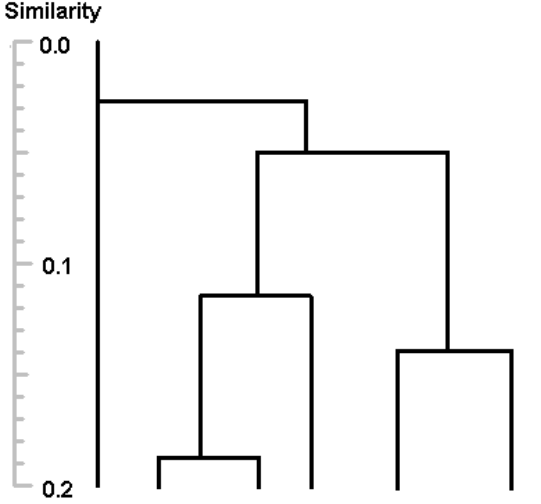
Figure 1. A typical dendrogram, generated by hierarchical clustering